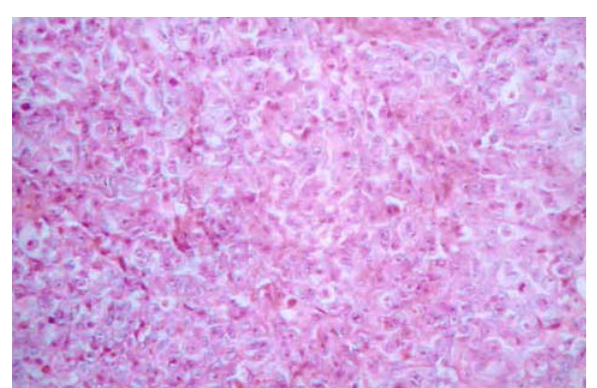
Figure 1 – Area of high grade urothelial carcinoma of the uri- nary bladder (HE, X100).